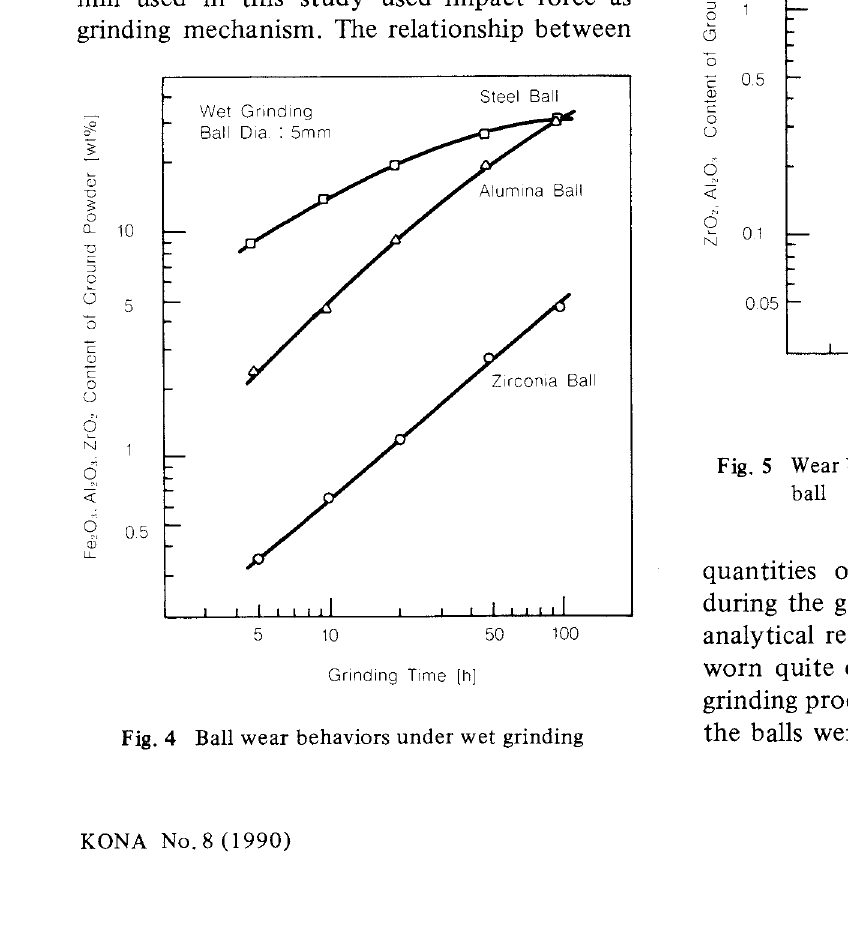
Fig. 4 Ball wear behaviors under wet grinding